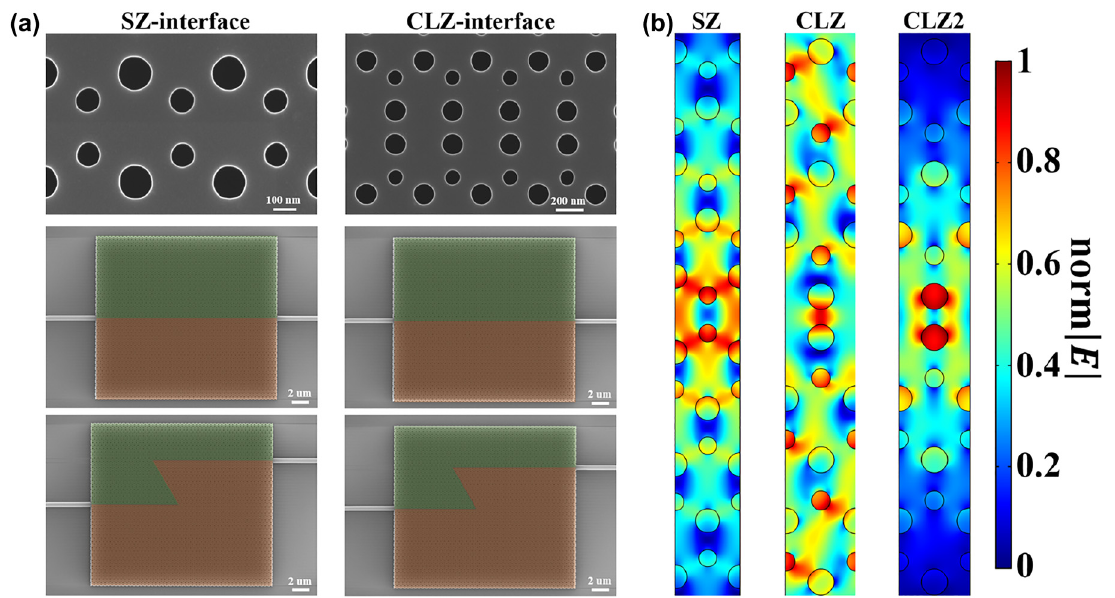
Figure 3: Analysis of optical modes in the topological interfaces. (a) SEM images of the straight and the Z-type domain walls constructed by the SZ- and CLZ-interfaces. (b) Normalized electric field (norm | E | ) distributions for the simulated optical modes supported by the SZ- and CLZ-interfaces,